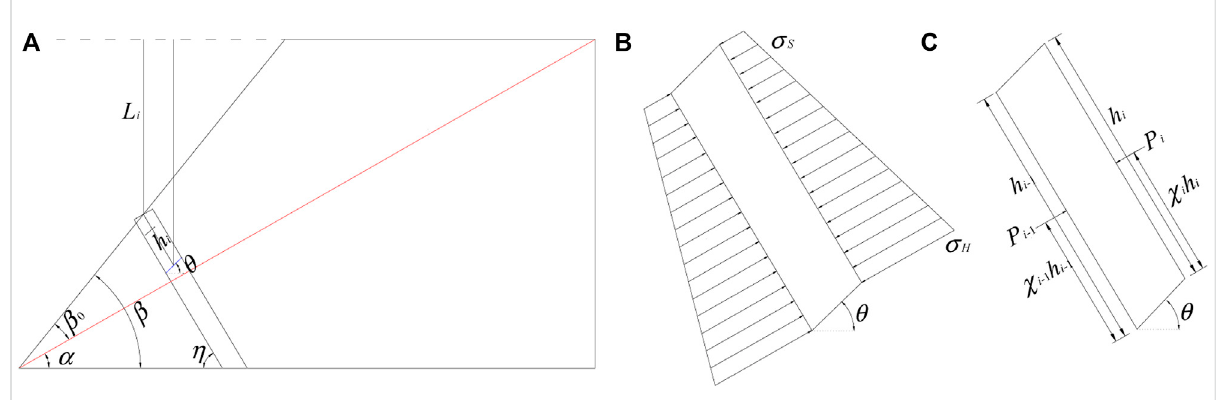
FIGURE 5 Anti-inclined bedded half space in fi nite slope: (A) mechanical model; (B) distribution of the interlayer force; (C) static equivalent substitution of the interlayer